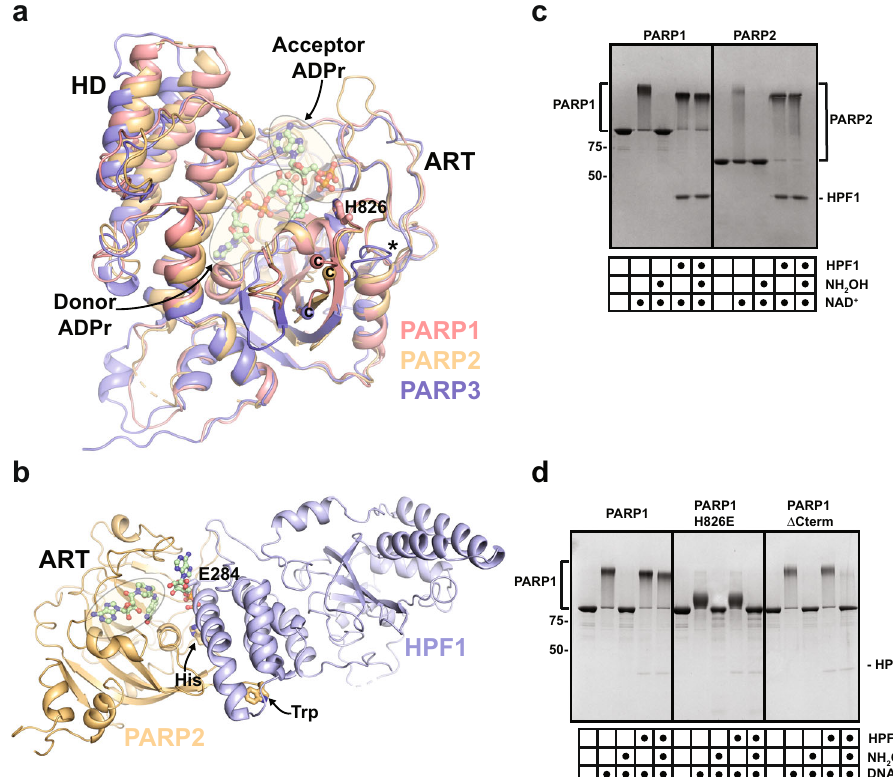
Fig. 1 HPF1 regulation of PARP1 and PARP2. a The catalytic domains of PARP1 (4DQY), PARP2 (4PJV), and PARP3 (3FHB) are superimposed. The helical domain (HD) and the ADP-ribosyltransferase (ART) domain are labeled. The Donor ADPr site is de fi ned by the PARP1 complex with BAD (6BHV), and the Acceptor ADPr site is de fi ned by the PARP1 complex with carba-NAD + (1A26). PARP1 and PARP2 share a similar structure of the loop that bears residue H826 (PARP1), whereas PARP3 has a truncated loop (*). PARP1 and PARP2 share conserved residues at their C-terminal ends that are not conserved in PARP3 (C-termini labeled “ C ” ). b The ART of PARP2 (HD deleted) in complex with HPF1 (6TX3). A conserved His residue from the loop highlighted in panel B (826 in PARP1), and a Trp residue at the C-terminus (1014 in PARP1), are drawn as sticks and labeled (His and Trp). The Donor site is bound by the NAD + mimic EB47 that was crystallized with the complex. HPF1 binding clashes with the Acceptor site (carba-NAD + is shown bound to the acceptor site as in panel B in order to highlight the clash). HPF1 residue E284 directly contributes to the PARP active site. c PARP1 or PARP2 (1 μ M) was incubated with dumbbell DNA containing a central nick (1 μ M) with or without HPF1 (1 μ M) for 10 min at room temperature (RT). 500 μ M NAD + was added for 5 min and reactions were quenched with 500 µ M PARP inhibitor (olaparib or talazoparib). Where indicated, reactions were treated with 1 M hydroxylamine (NH 2 OH) for one hour. Reactions were resolved by SDS-PAGE and treated with Imperial Stain. d Same as panel c for PARP1 WT, mutant H826E, and mutant Δ Cterm ( Δ 1012 – 1014), with 0.1 μ M of HPF1. The experiment in c was performed three times. The experiment in d was performed two times. Numbers on the left side of the gels represent molecular weight marker locations (values in kDa). Source data are provided as a Source Data fi